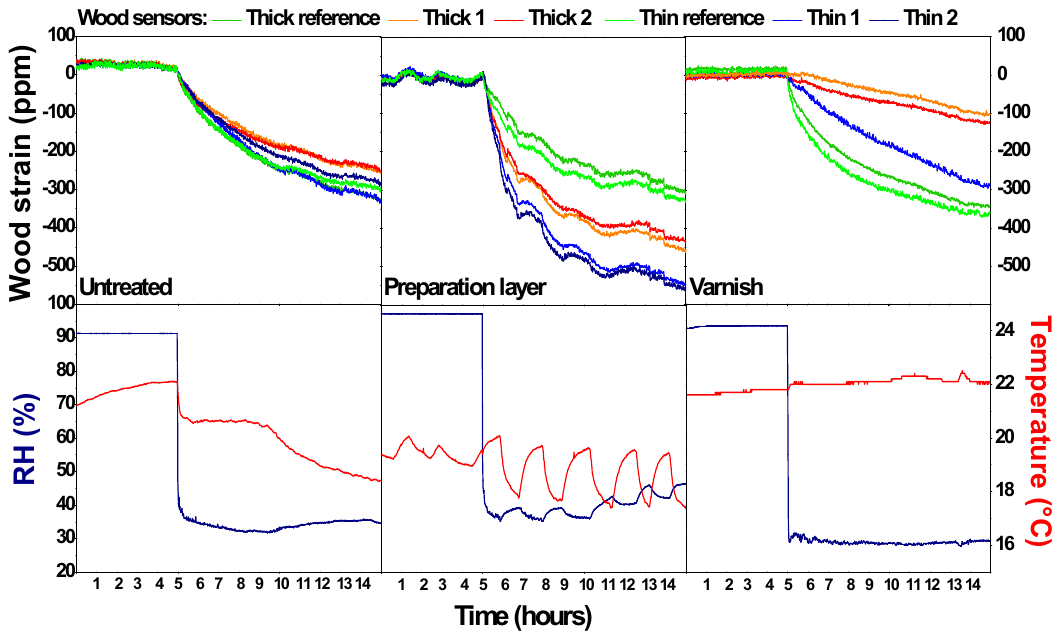
Figure 4. Dimensional response of the wood sensors for an RH step decrease generated in a closed box in three different situations: (1) untreated wood, (2) wood with a preparation layer, and (3) wood with a preparation and varnish layer. The corresponding temperature and relative humidity conditions are shown for each situation.